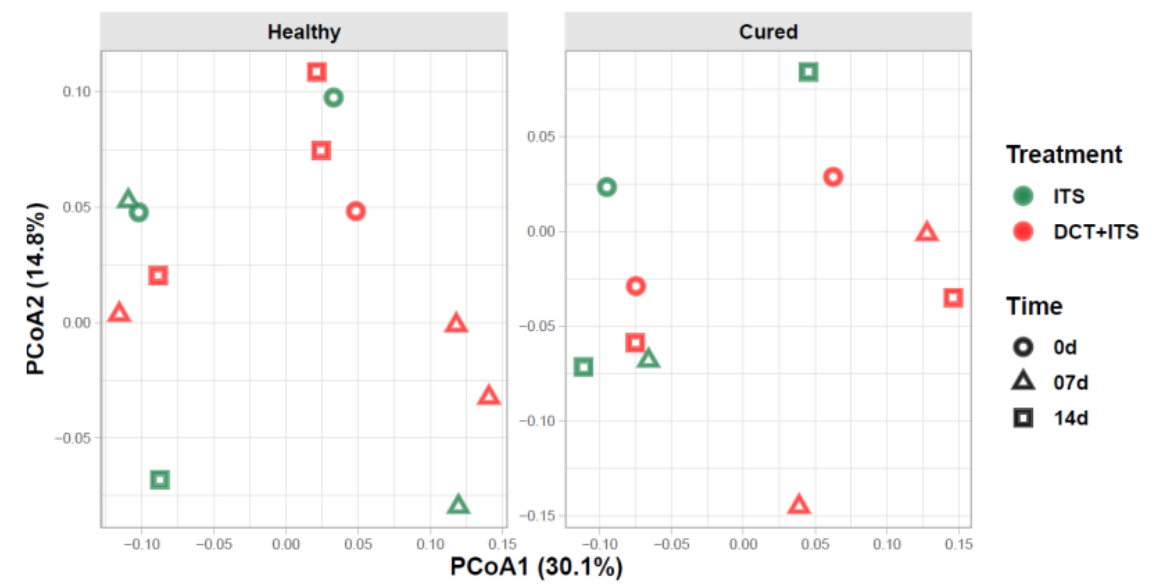
Figure 2. Beta diversity of bacterial communities of the milk samples. Principal coordinate analysis (PCoA) showing the Bray-Curtis dissimilarities in the composition of bacterial communities between milk sample grouped according to category (Healthy and Cured), treatment (ITS and DCT+ITS), and time of sampling (0 d: the day of drying-off, 7 d: 7 days after calving, and 14 d: 14 days after calving). Individual points in each plot represent a milk sample, while different colors and shapes represent treatments and time of sampling, respectively. Percentages shown along the axes represent the proportion of dissimilarities captured by PCoA in a two-dimensional (2D) coordinate space.